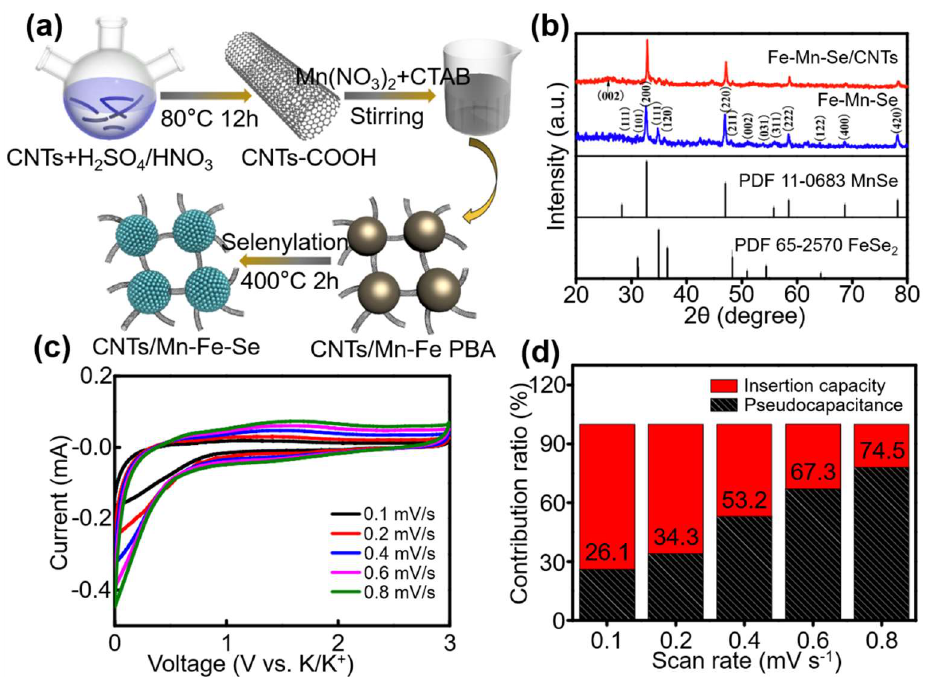
Figure 6. ( a ) Schematic representation of Mn-Fe-Se/CNTs composite. ( b ) XRD analysis of Mn-Fe-Se and Mn-Fe-Se/CNTs composites. ( c ) CV profiles at different scan rates. ( d ) Contribution ratio of capacitive current and diffusion-controlled current versus scan rate of Mn-Fe-Se/CNTs electrode for PIBs. Ref. [19] Copyright Chemical Engineering Journal, Elsevier.